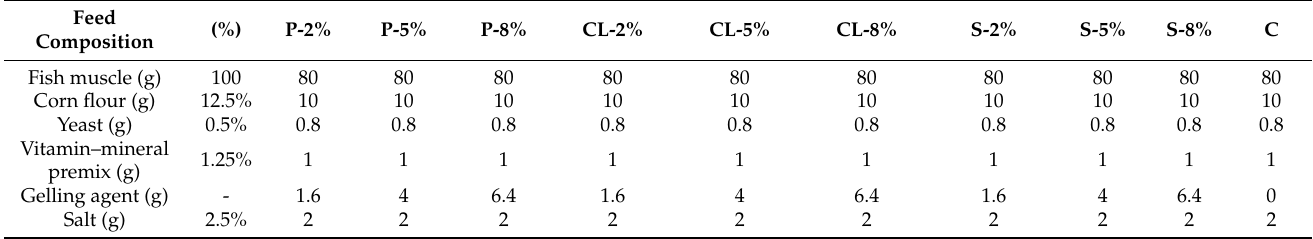
Table 5. Ingredient composition of experimental gel feed for Puntius conchonius